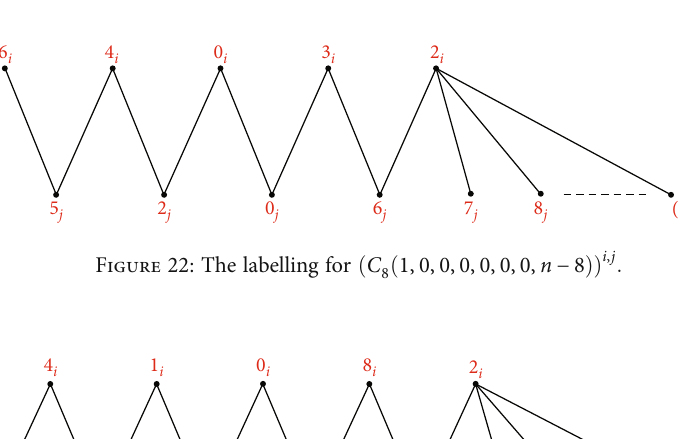
1, 0, 0, 0, 0, 0, n − 7 ÞÞ i , j : 7 ð